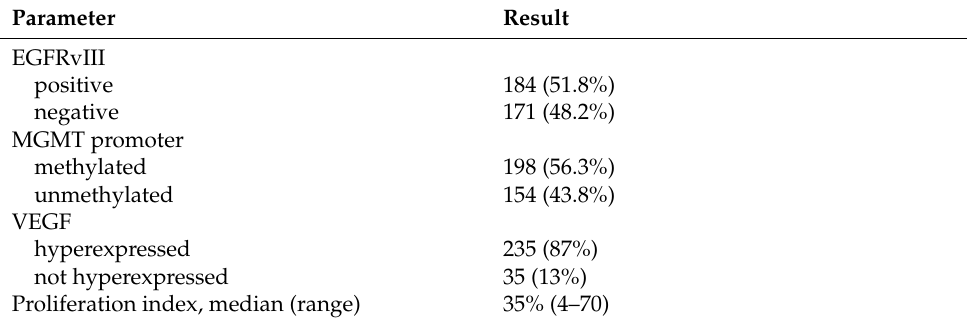
Table 2. Molecular characteristics of